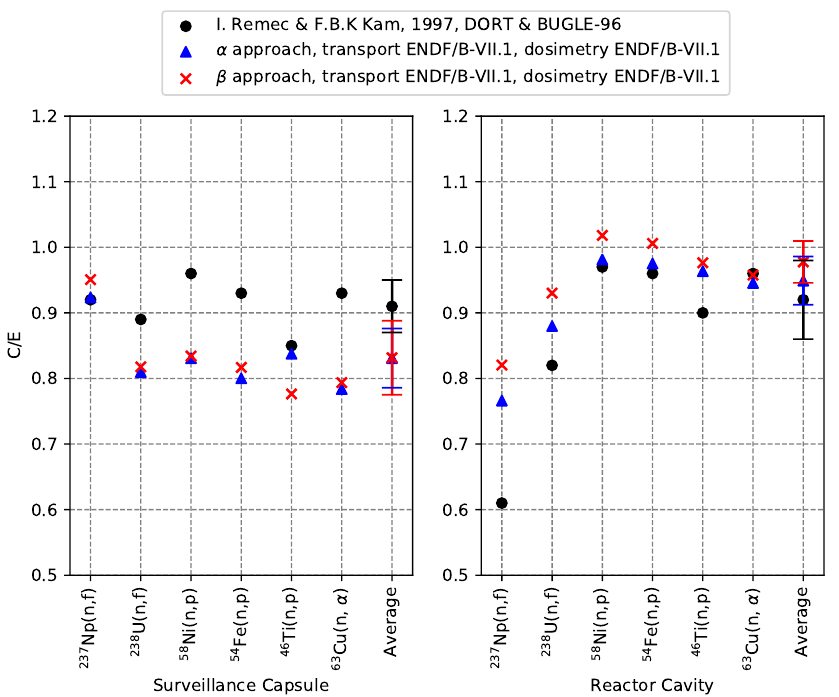
Figure 8. C/E ratios obtained with the α and β approaches using the ENDF/B-VII.1 nuclear data library. The results obtained by I. Remec and F.B.K. Kam [11] are shown for comparison. The 237 Np(n,f) specific activity is not taken into account in the calculation of the average C/E value in the